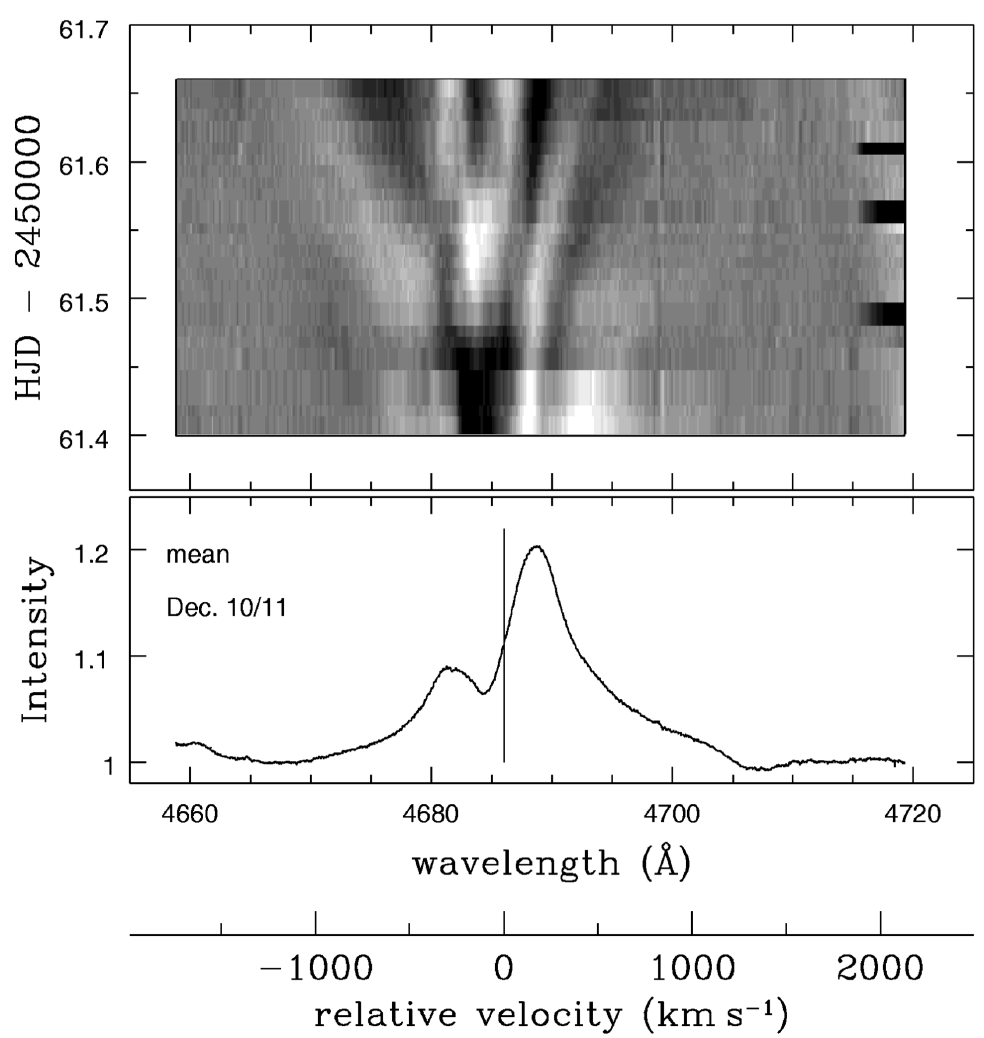
Figure 4. Top: Dynamic difference spectrum of the first direct discovery of clumping in the wind of an O-type star, here for ζ Pup [19]. Bottom: Corresponding mean spectrum of the He II λ 4686 emission line with P Cygni profile, arising in the wind of ζ Pup for the same night. This observation was obtained in 1995 at the coudé focus of the 3.6 m Canada-France-Hawaii Telescope. Another similar observation was made two nights later. ©AAS. Reproduced with